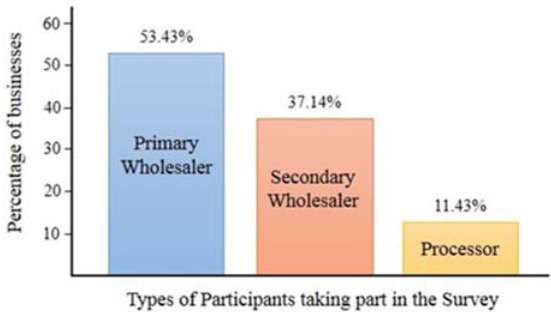
Figure 2. Percentage participation of wholesalers and processors located at Market City Canning Vale, Perth, Western Australia.